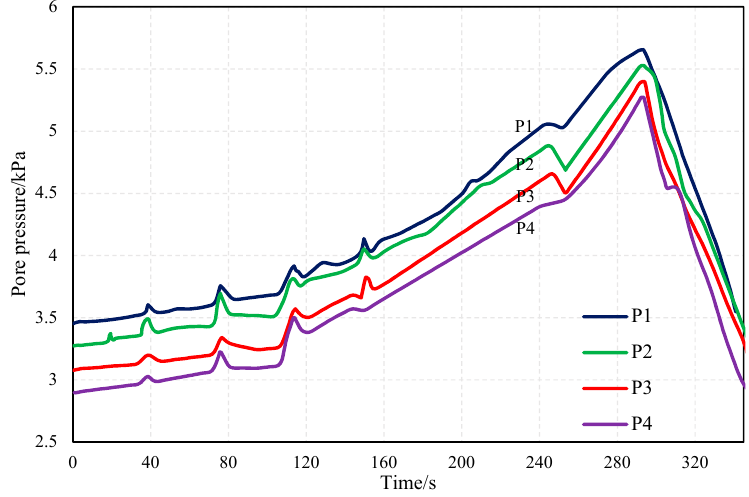
Figure 17. Measured pore pressure for Model 13-5.